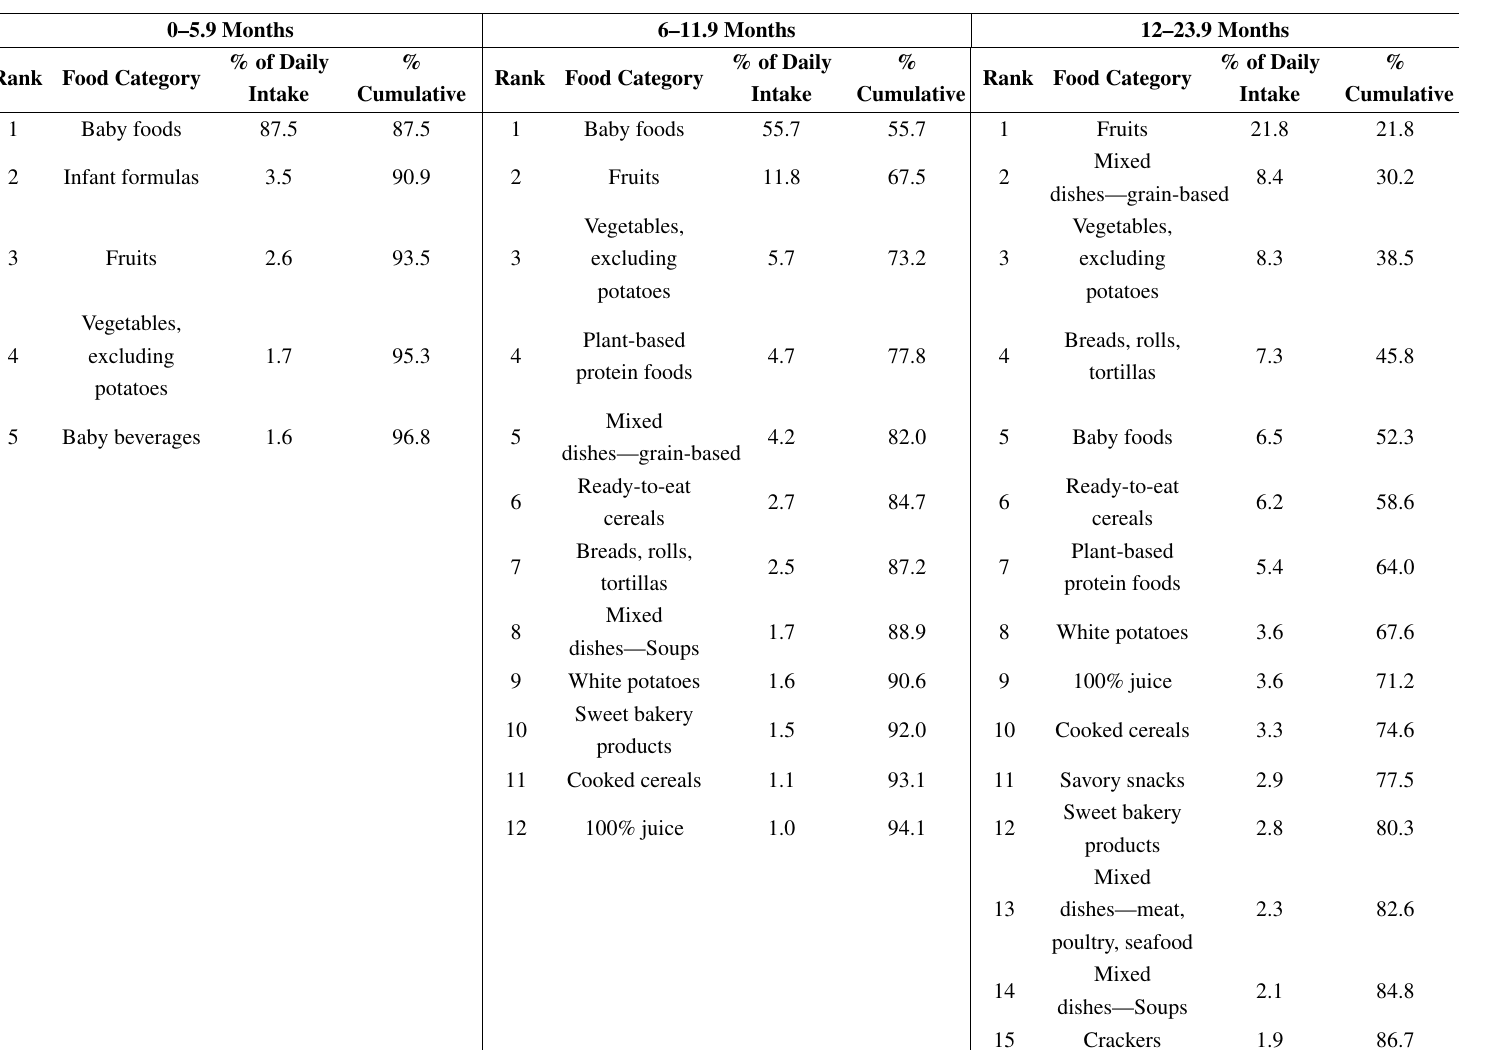
Table 8. Food sources of fiber among US infants and toddlers aged 0–23.9 months by age group: NHANES 2005–2012 ( n = 2740) a